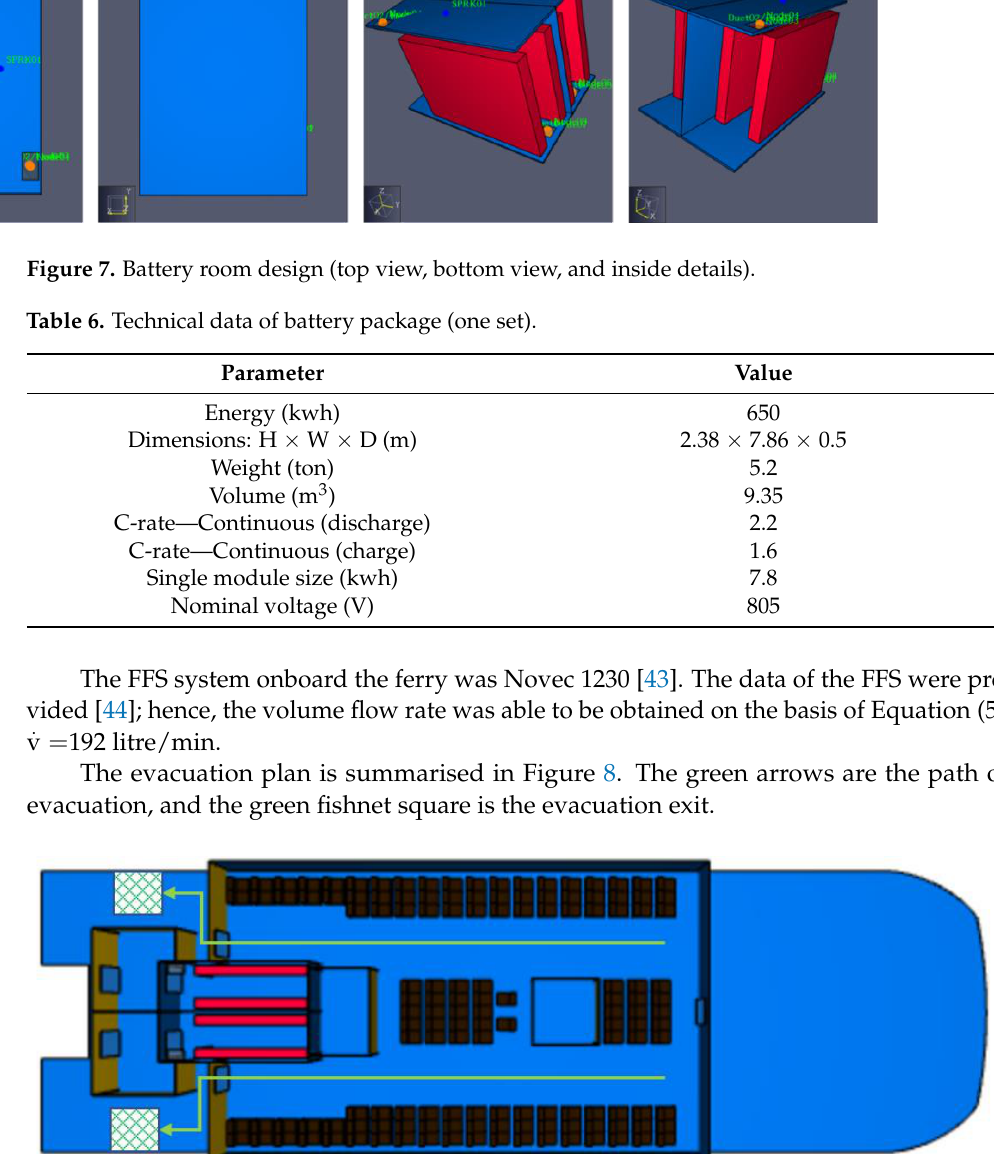
Figure 7. Battery room design (top view, bottom view, and inside details).